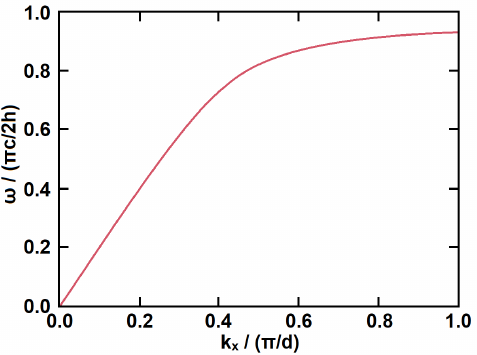
Figure 2. Dispersion curves of surface waves on one-dimensional metal structure with periodic grooves. Transmission lines loaded periodically with reactive elements are periodic structures, which can be made in various forms related to the properties of the transmission line. The periodic serpentine lines can be used to increase the unit capacitance of the transmission line and increase slow-wave effects. The schematic diagram of the serpentine structure is shown in Figure 3. It is composed of multiple sub-branches with the gap s 1 , length h 1 , and line width w 1 . When the straight line is folded to the serpentine line, the extra electric coupling can be generated in the corner of the serpentine line. This can be regarded as a short segment of the self-coupling line; therefore, the distributed capacitance has been increased.